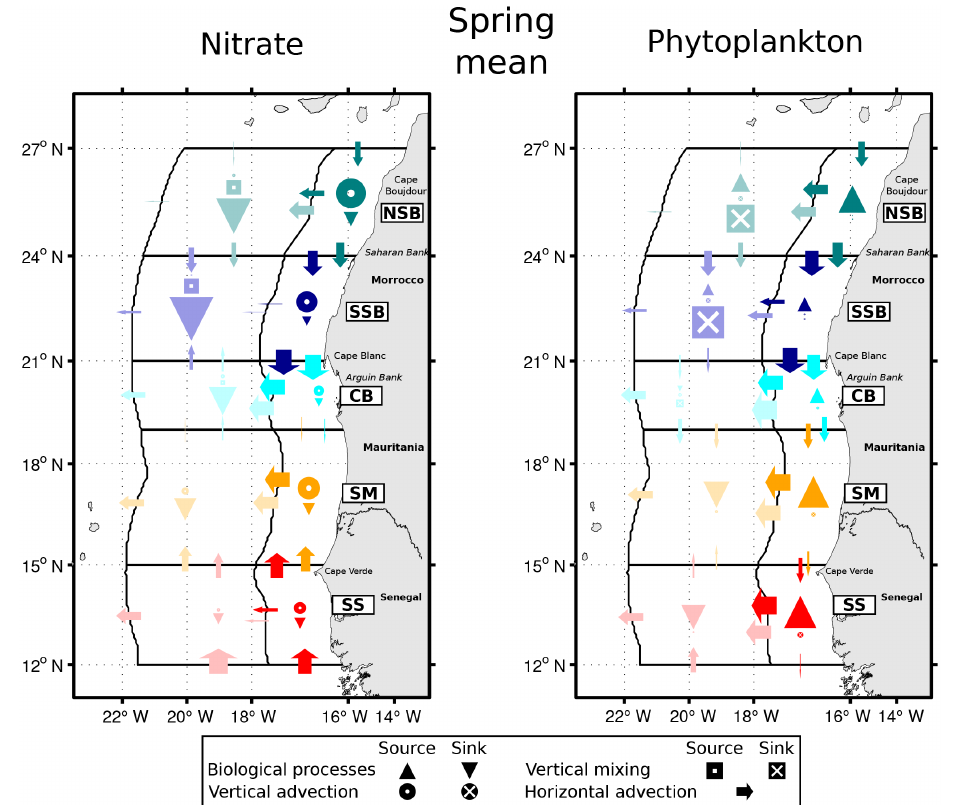
Figure 13. Schematic of the spring mean contribution of the different source and sink terms of nitrate and phytoplankton concentration within each box defined in this study. Each colour corresponds to a box (see legends in Fig. 2 for coastal and Fig. 8 for offshore boxes): northern Saharan Bank (NSB), southern Saharan Bank (SSB), Cape Blanc area (CB), Senegalo-Mauritanian region (SM) and southern Senegal region (SS). Arrows indicate horizontal advection, circles indicate vertical advection, squares indicate vertical mixing and triangles indicate biological processes. Within a circle or square, a white point indicates a source while a white cross indicates a sink; biological processes are a source (sink) if a triangle heads upward (downward). The size of arrows, circles, squares and triangles indicates the magnitude of the contribution of each source and/or sink term. For offshore boxes, the information is equivalent to that given in Fig.